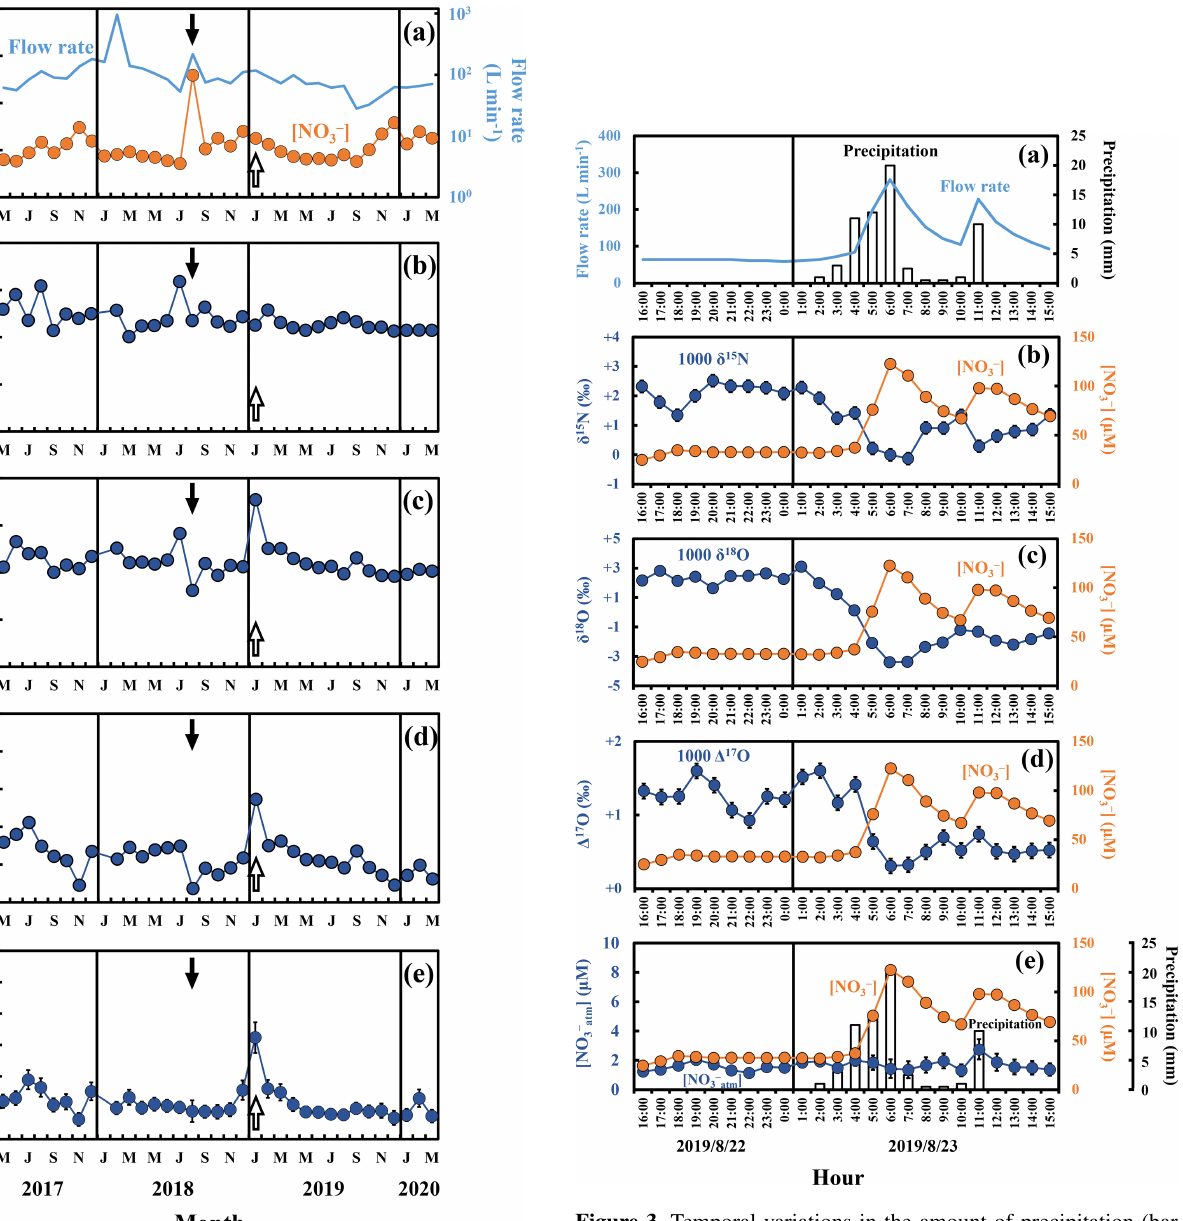
Figure 3. Temporal variations in the amount of precipitation (bar chart) and flow rates of the stream water (blue line) during storm Figure 2. Temporal variations in the concentrations of nitrate (or- event I (a) , together with those in the concentrations of nitrate (or- ange circles) and the flow rates (blue line) in the stream water dur- ange circles) (b–e) , the values of δ 15 N (b) , δ 18 O (c) , (cid:49) 17 O (d) of ing the routine observation (a) , together with those of the values of nitrate, and [NO − ] (e) in the stream water (blue circles). The 3 atm δ 15 N (b) , δ 18 O (c) , (cid:49) 17 O (d) of nitrate, and the concentrations of error bars smaller than the sizes of the symbols are not unprocessed atmospheric nitrate ([NO − ]) (e) in the stream water 3 atm (blue circles). The black and white arrows in the figures indicate the sampling that took place on 31 August 2018 and 31 January 2019, respectively. The error bars smaller than the sizes of the symbols are not presented.